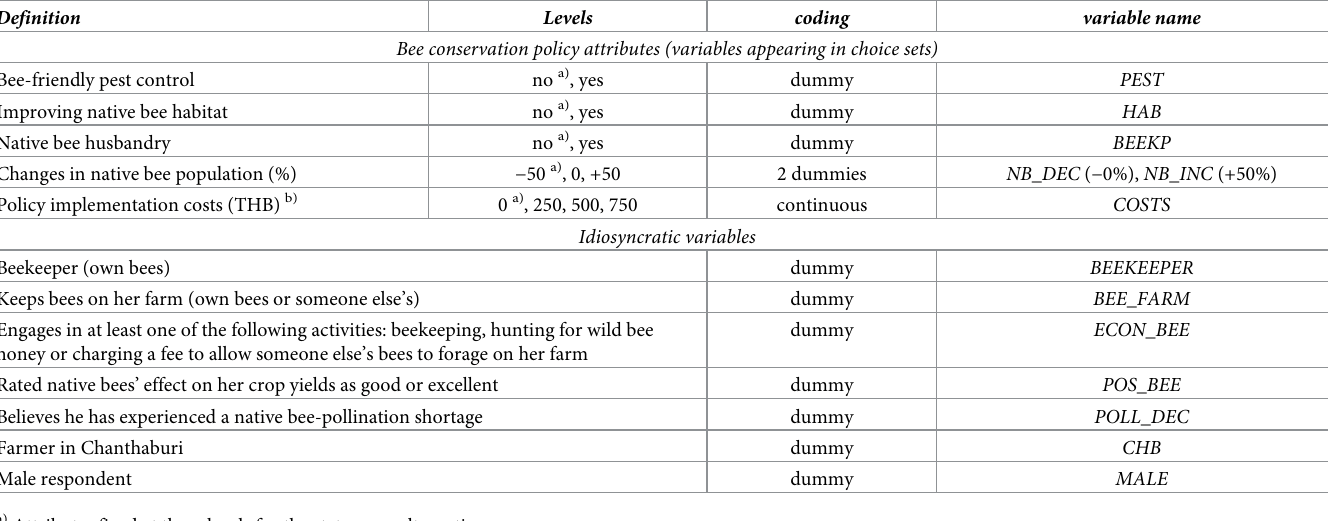
Table 1. Choice alternative attributes, corresponding design levels and other variable